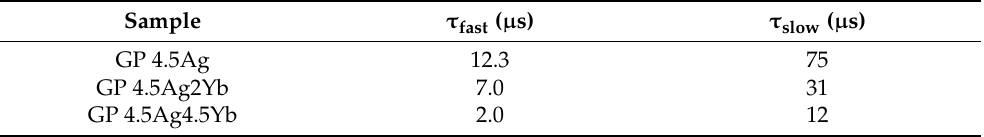
Table 3. PL decay lifetimes (fast and slow components) of Ag NCs: GP 4.5Ag, GP 4.5Ag2Yb, and